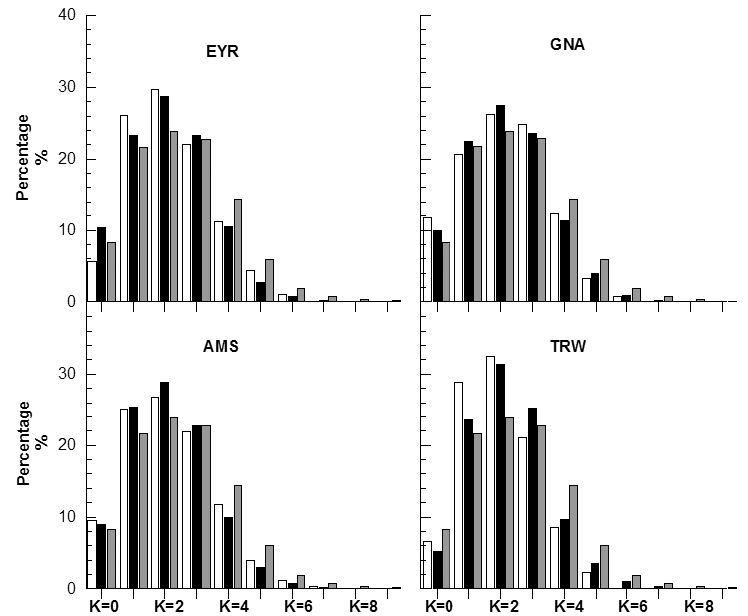
Figure 8. Comparison between the frequency distributions of K-real (black bar), Kn (white bar) and Kp (grey bar) for 4 observatories which are inside the influence zone of the